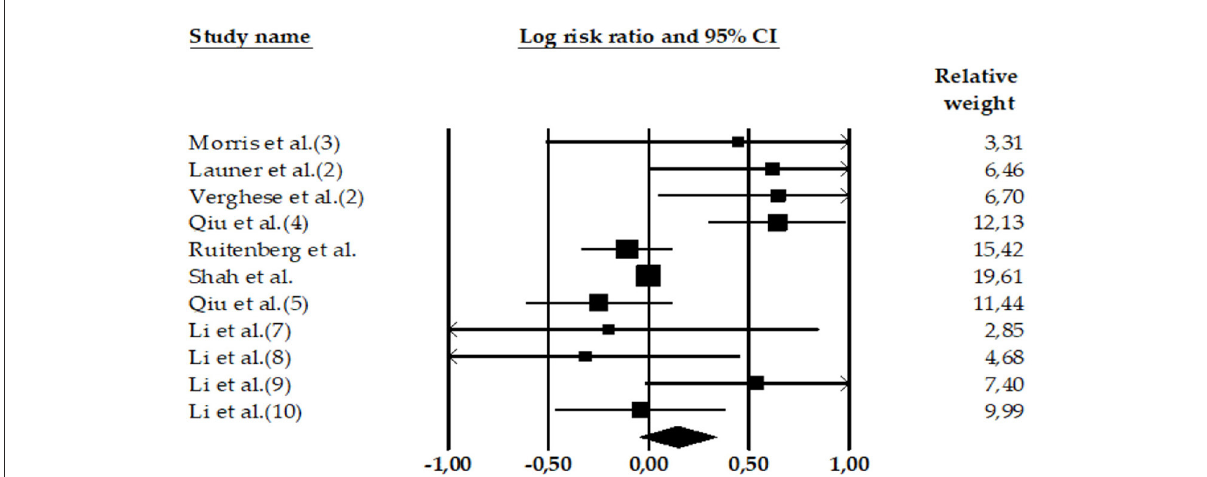
FIGURE3 Forest plot of the meta-analysis of incidence rates of AD in participants with high DBP. Individual and pooled effect estimates of the association between DBP hypertension and AD. The size of the box representing the point estimate for each study in the forest plot is proportional to the contributing weight of that study estimate to the summary estimate.